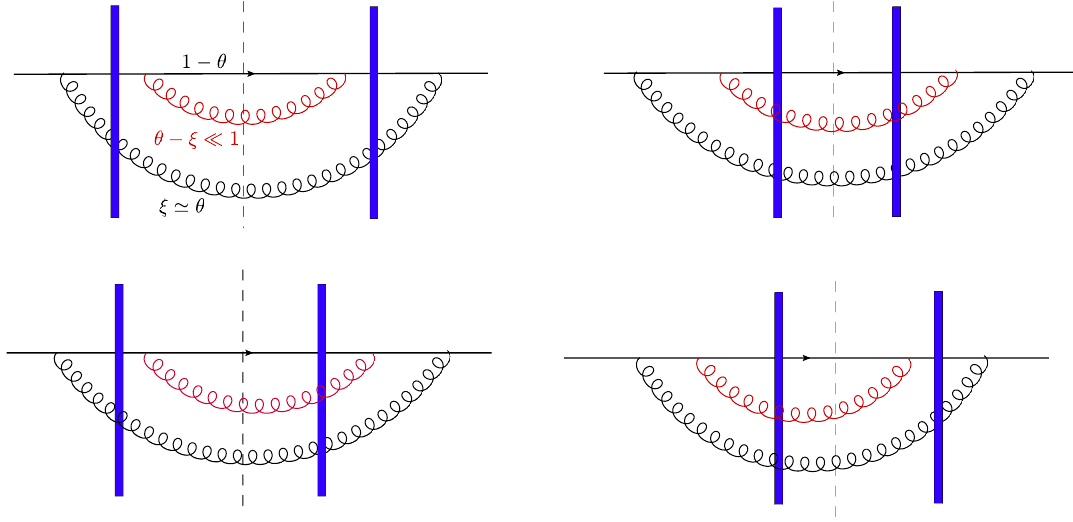
Figure 14 . The four diagrams contributing to the cross-section (3.39) which survive in the eikonal limit θ − ξ → 0 in which the second emitted gluon (shown in red) is